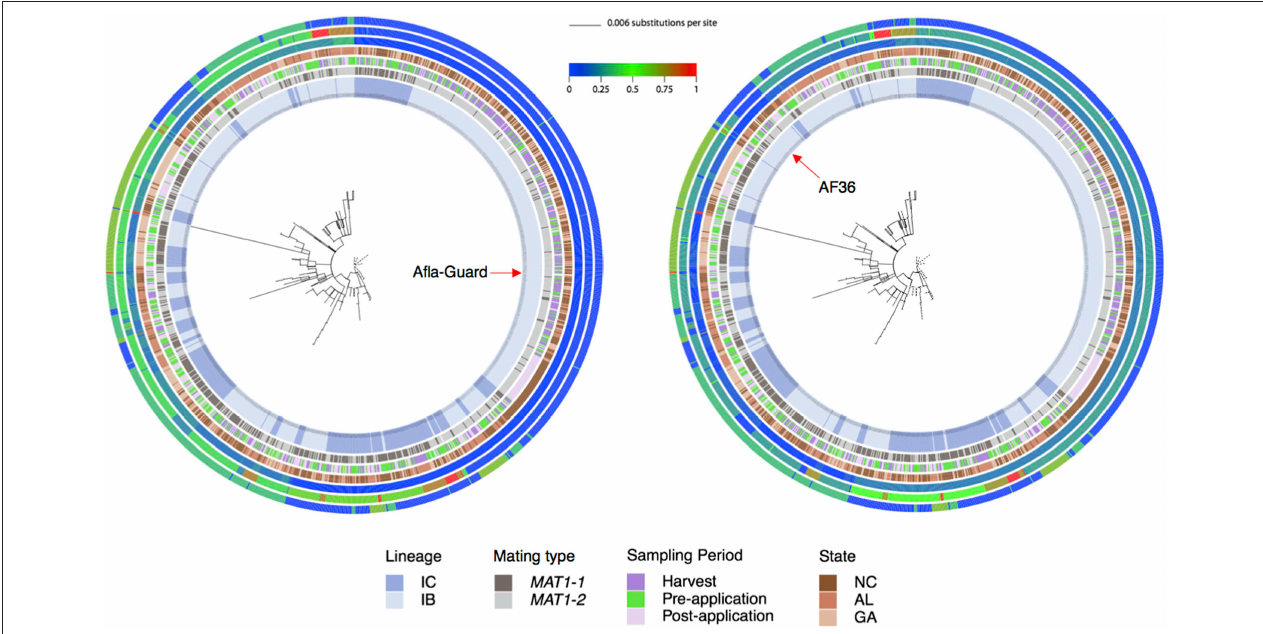
FIGURE 3 | Phylogenetic relationships showing patristic distances of 1,282 A. flavus isolates to the Afla-Guard strain (radial tree on left) or the AF36 strain (radial tree on right). In the center of each radial ring is the best maximum likelihood tree for the combined MLST loci ( trpC , AF17, and mfs ) with branches drawn to scale (scale bar is shown at the top). The four innermost rings represent A. flavus lineage as inferred from principal component analysis, mating type, sampling period, and state, respectively. The three outermost rings represent patristic distances for AF17, mfs , and trpC , respectively. The distance of each isolate from Afla-Guard or AF36 as a reference is shown using a heat map, where a value of 0 (blue) indicates high genetic similarity of the strain to the reference and a value of 1 (red) is high genetic